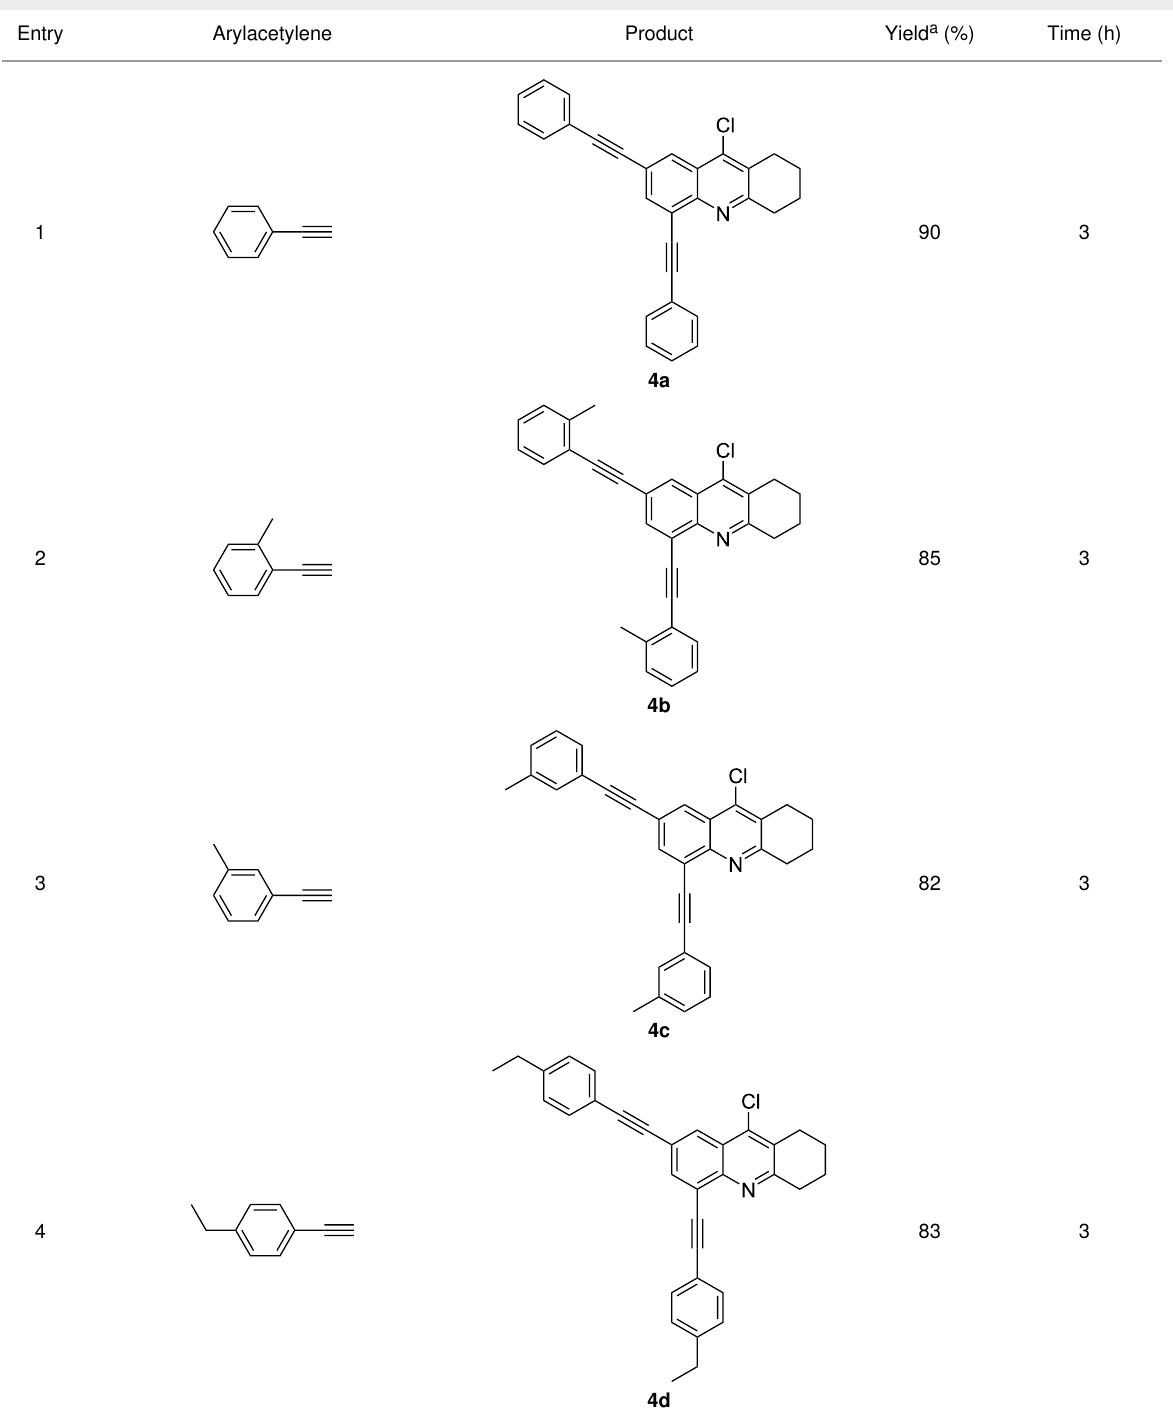
Table 3. Aiming to understand the impact of substituents